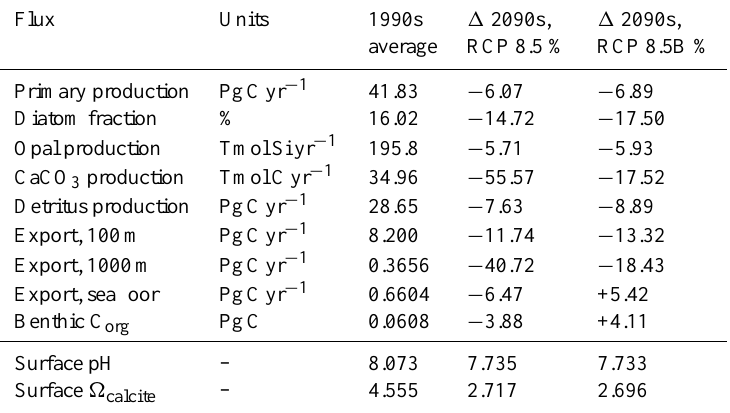
Table 5. Major biogeochemical fluxes, RCP 8.5B versus RCP 8.5. Note that the 1 2090s values shown for surface pH and (cid:127) calcite are instead 2090s